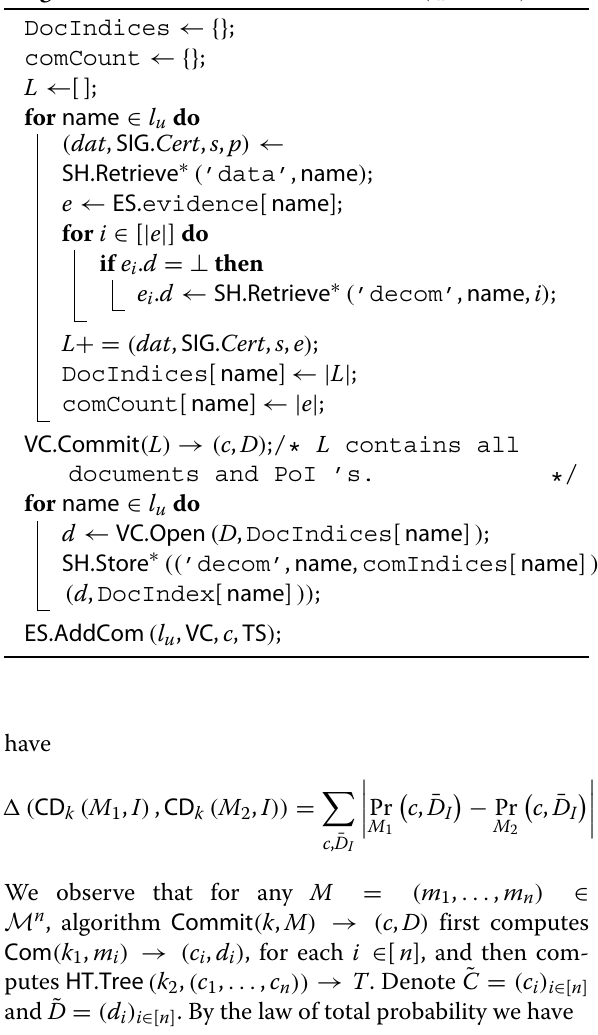
Algorithm 16: MCELSA . userRenewCom ( l u , VC , TS